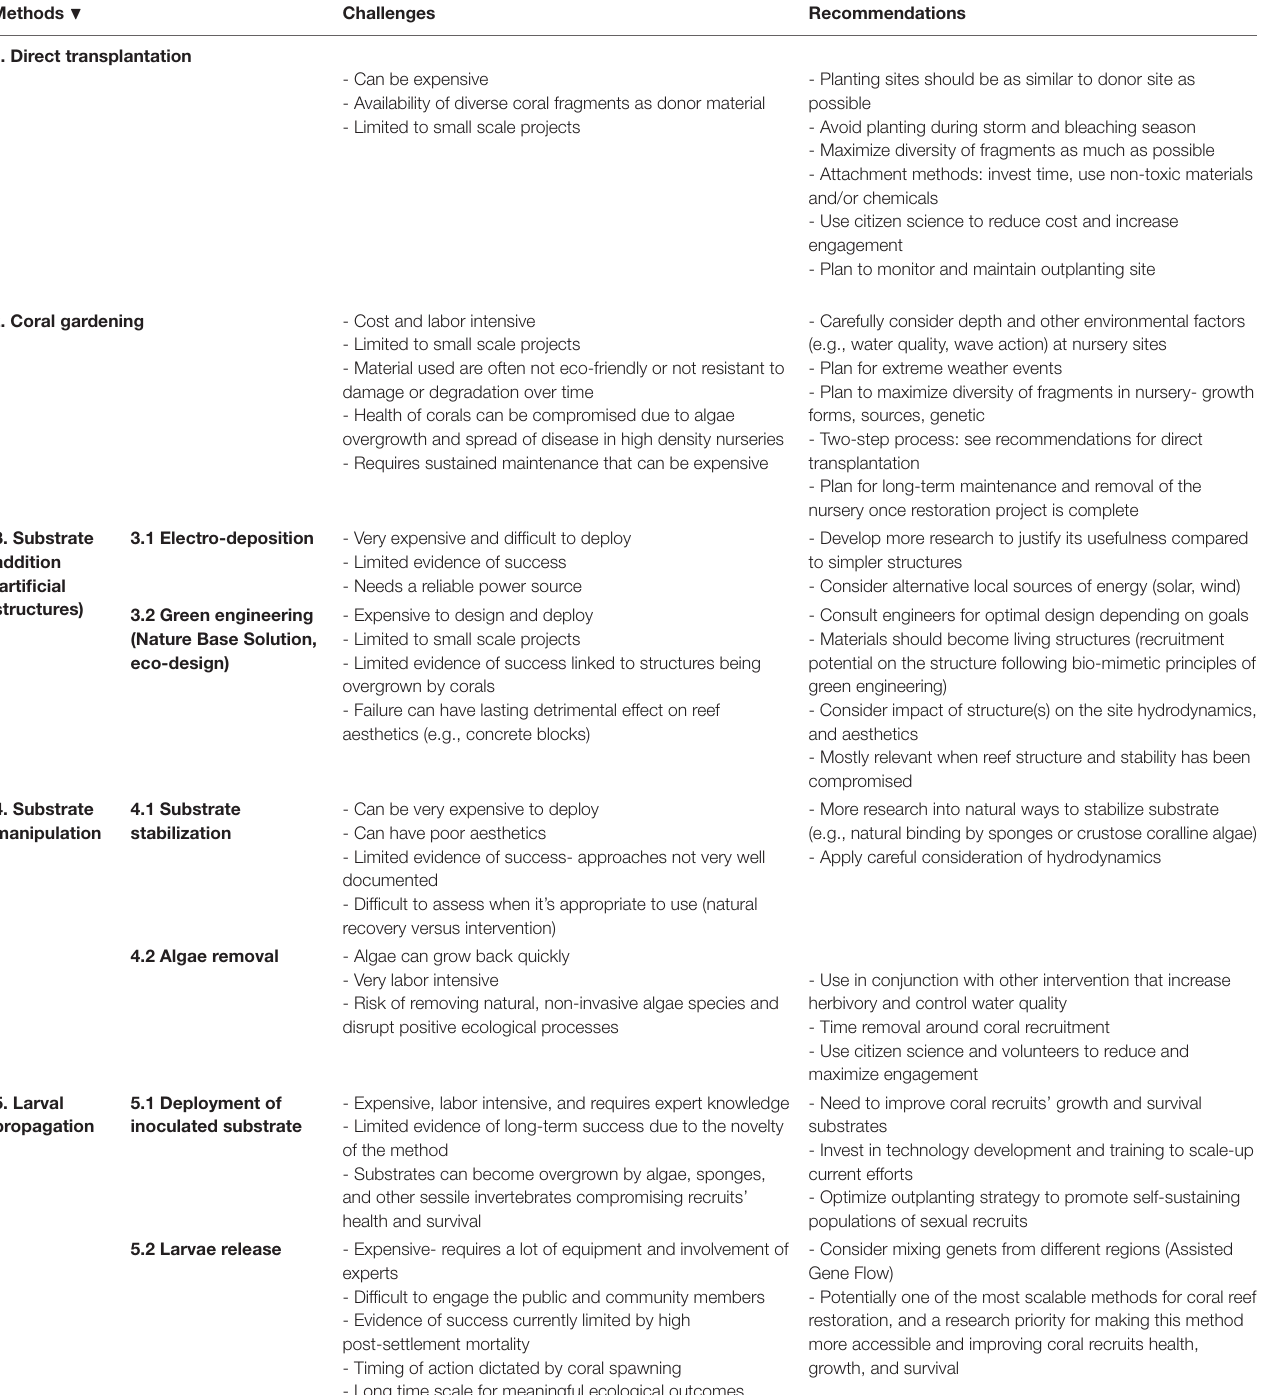
TABLE 4 | Specific challenges and recommendations for each of the currently established methods of coral reef restoration. Methods